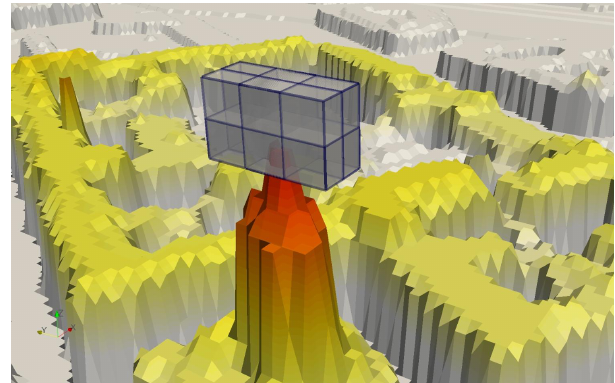
Figure 4. Example discretization of target volume V T into n x × n y × n z subvolumes. A coarse illustration with n x = 2, n y = 3, and n z = 2 is